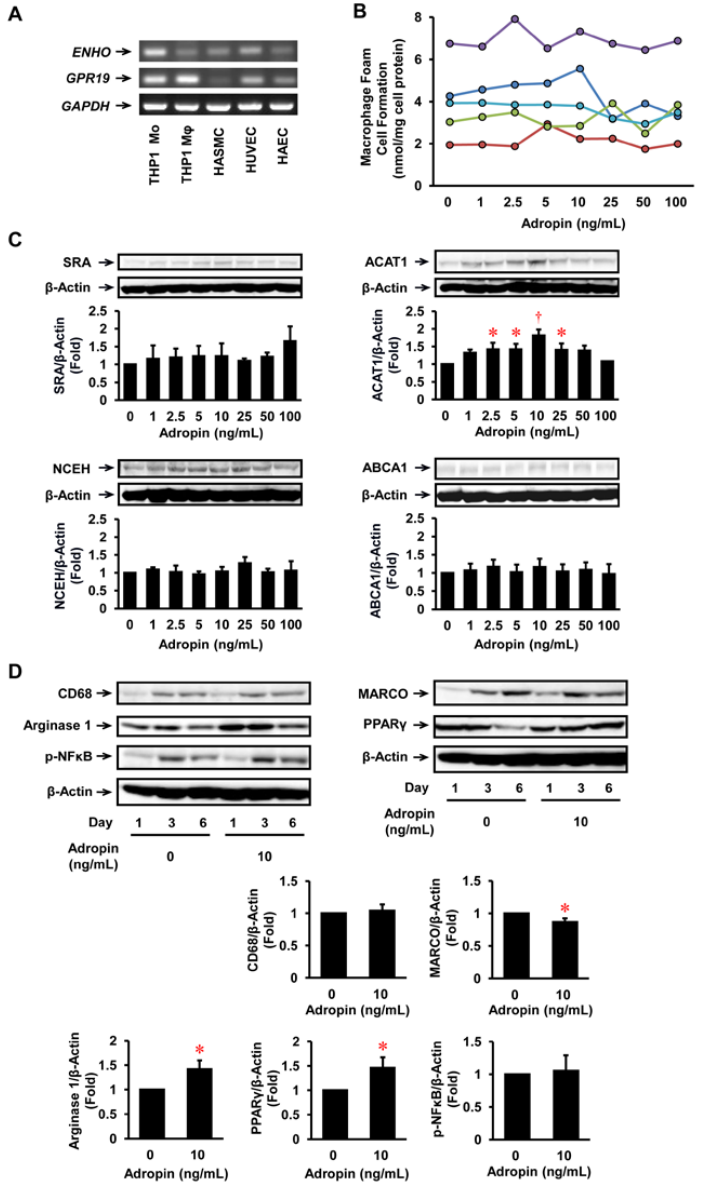
Figure 2. Expression of ENHO (adropin gene) and GPR19 in human vascular cells and the effect of adropin on foam cell formation and inflammatory phenotype in THP1 monocyte-derived macrophages. ( A ) mRNA expression levels of ENHO and GPR19 in THP1 monocytes, their derived macrophages, HASMCs, HUVECs, and HAECs were analyzed by RT-PCR. Glyceraldehyde-3-dehydrogenase ( GAPDH ) served as a loading control. Independent experiments were repeated twice to assure reproducibility. ( B ) THP1 monocytes were incubated for 6 days with the indicated concentrations of adropin, followed by a 19-h incubation with 50 µ g/mL oxidized LDL in the presence of 100 µ mol/L [ 3 H]oleate. Foam cell formation was determined from reads of the intracellular radioactivity of cholesterol-[ 3 H]oleate ( n = 5). The results from 5 independent experiments are shown in different colors. ( C ) THP1 monocyte-derived macrophages cultured for 6 days were harvested before the addition of oxidized LDL for immunoblot for SRA, ACAT1, NCEH, ABCA1, and β -actin ( n = 5–6). ( D ) THP1 monocytes were incubated for the indicated times with or without adropin (10 ng/mL). Cells were subjected to immunoblot for CD68 (a macrophage differentiation marker), MARCO (an M1 macrophage marker), arginase 1 (an M2 macrophage marker), p-NF κ B, PPAR γ , or β -actin ( n = 3–4). The graph shows the expressions on day 6. * p < 0.05, † p < 0.005 vs. 0 ng/mL of